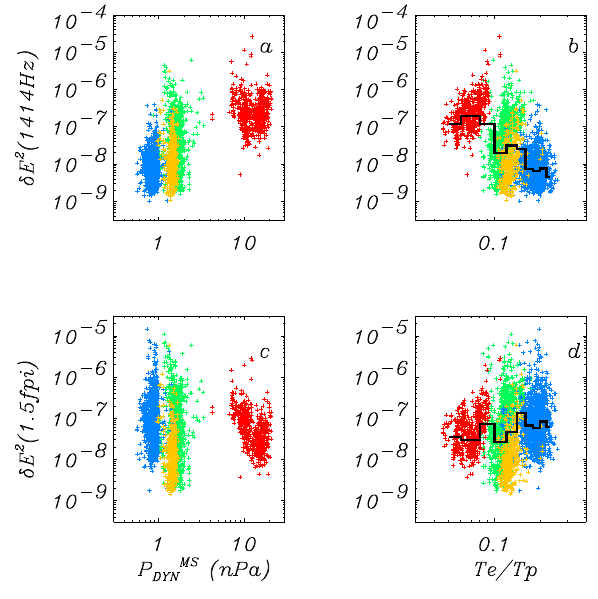
◦ Figure5:Forthetimeintervalswhen Θ BV inthemagnetosheathisbetween70 2 MS DYN ◦ and110 ,a)andb)thee.s.PSD δE at1414Hzasafun tionof P and T e /T p , )andd)thee.s.PSD δE 2 ( f ) ,interpolatedatthetimevaryingfrequen y Fig. 5. For the time intervals when 2 BV in the magnetosheath is MS DYN 1.5 f pi ,asafun tionof P and T e /T p .Thebrokenbla klinesgivethemedian between 70 ◦ and 110 ◦ , (a) and (b) the e.s. PSD δE 2 at 1414Hz as valuesinbinsof T e /T p withawidth0.02.5 a function of P MS and T e /T p , (c) and (d) the e.s. PSD δE 2 (f ) , DYN interpolated at the time varying frequency 1.5 f pi , as a function of P MS and T e /T p . The broken black lines give the median values DYN in bins of T e /T p with a width